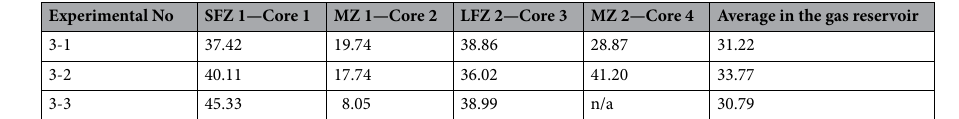
Table 10. Water saturation increment in different zones at the end of Group III (%).